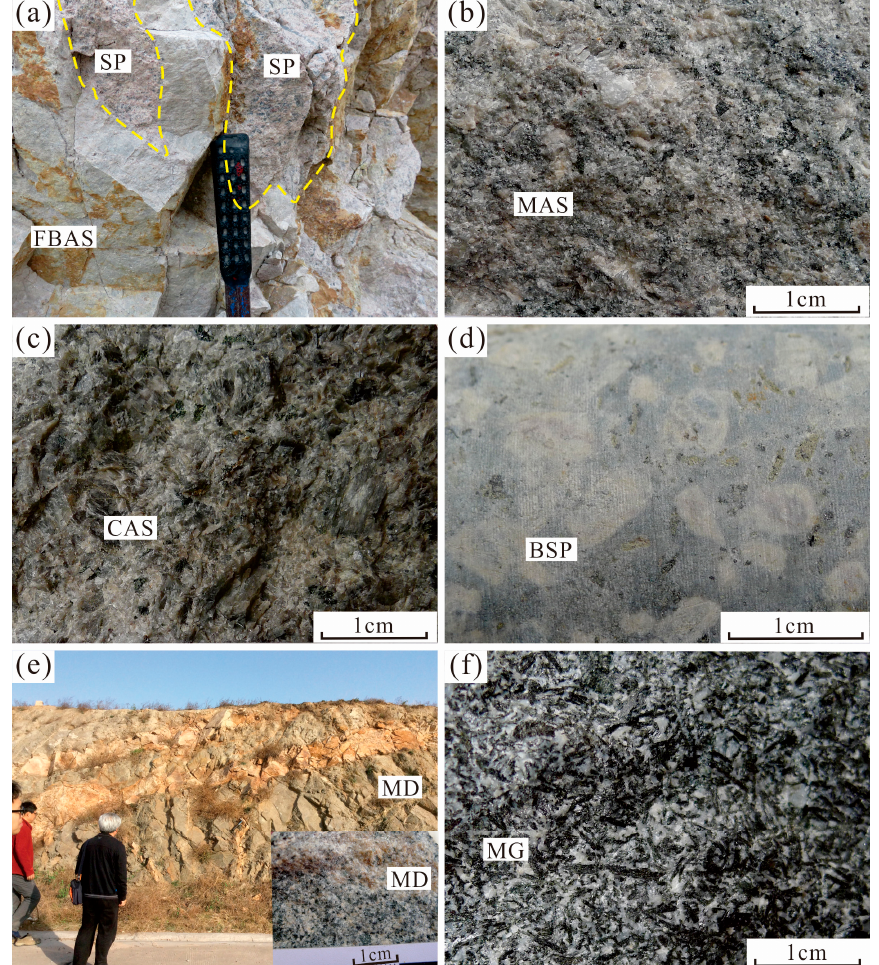
Figure 3. Characteristics of field and hand specimens of the Hongshan complex. ( a ) The fine-grained biotite aegirine syenite (FBAS) and syenite pegmatite (SP), showing that the fine-grained biotite aegirine syenite (FBAS) is emplaced by the syenite pegmatite (SP); ( b ) The medium-grained aegirine gabbro syenite (MAS); ( c ) The coarse-grained aegirine gabbro syenite (CAS); ( d ) The biotite syenite porphyry (BSP); ( e ) The vein fine-grained biotite hornblende monzo-diorite (MD) that intruded in syenite; ( f ) The fine-grained hornblende monzo-gabbro (GD). (4) Syenite pegmatite